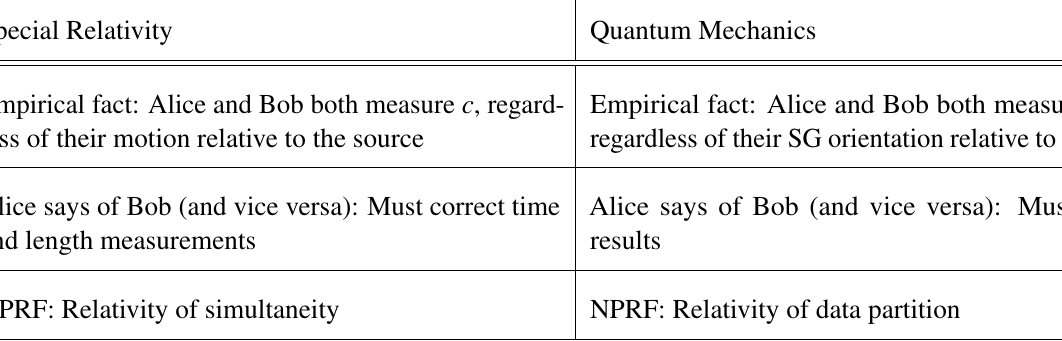
Figure 10: Comparing SR with QM according to no preferred reference frame (NPRF). Because Alice and Bob both measure the same speed of light c, regardless of their motion relative to the source per NPRF, Alice(Bob) may claim that Bob’s(Alice’s) length and time measurements are erroneous and need to be corrected (length contraction and time dilation). Likewise, because Alice and Bob both measure the same values for spin angular momentum ± 1 relative to the source per NPRF, Alice(Bob) may claim that Bob’s(Alice’s) individual ± 1 values are erroneous and need to